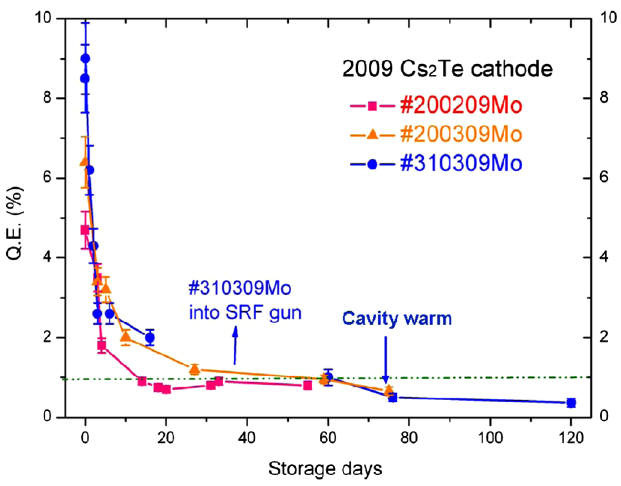
FIG. 4. (Color) Long-term behavior of Cs 2 Te